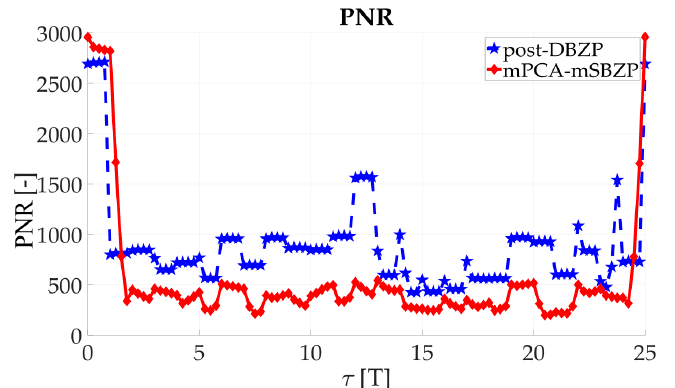
Figure 21. PNR result of the proposed modified processing, in an entire period of SC .